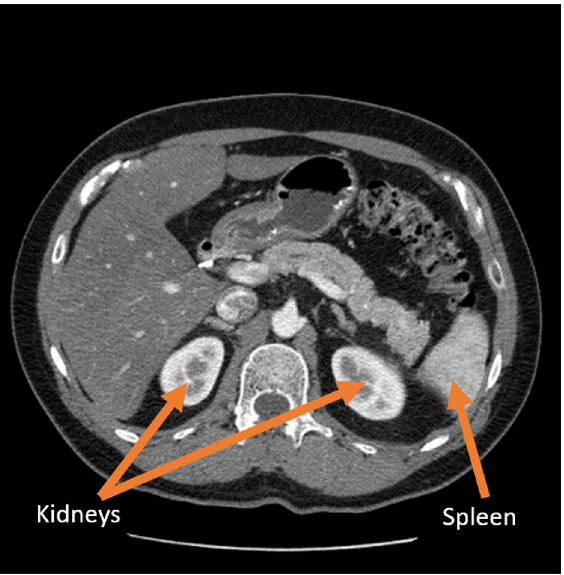
Figure 1. Example of a selected original CT section. The orange arrows indicate the labeled organs marked by an expert: Kidneys and Spleen, which are in the area of interest of the